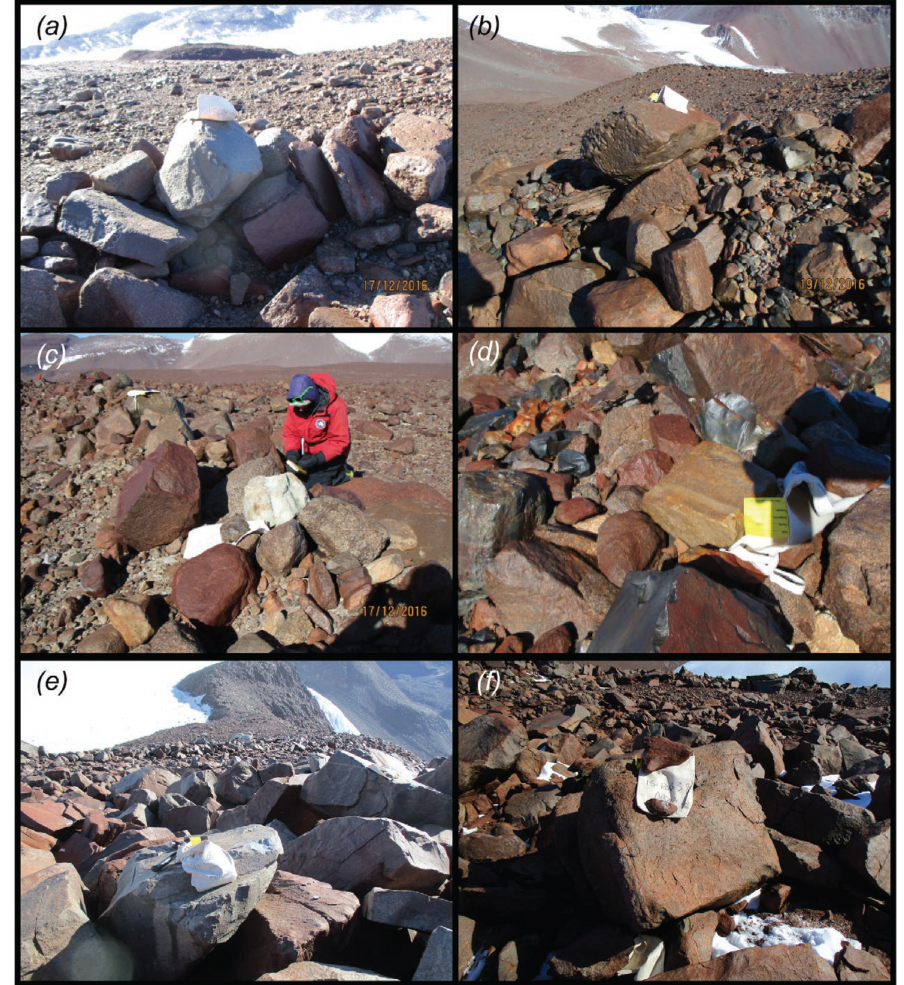
Figure 6. Photographs of moraines and sampled boulders at Roberts Massif. (a) Blue-gray dolerite boulder 16-ROB-010-NLO on the second moraine from the modern EAIS in the Lower Roberts northern transect; (b) red-stained dolerite boulder 16-ROB-059-RIN on the Ringleader moraine, the outermost moraine in the Lower Roberts area; (c) relatively unweathered sandstone boulder 16-ROB-009-NLO; (d) red-stained and varnished sandstone boulder 16-ROB-062-RIN on the Ringleader moraine; (e) relatively unweathered, blue-gray dolerite boulder 15- ROB-064-MUS on the Musik moraine, the innermost moraine at Upper Roberts; and (f) weathered and red-stained dolerite boulder 15-ROB- 038-ARM on the Arena moraine, the outermost moraine at Upper